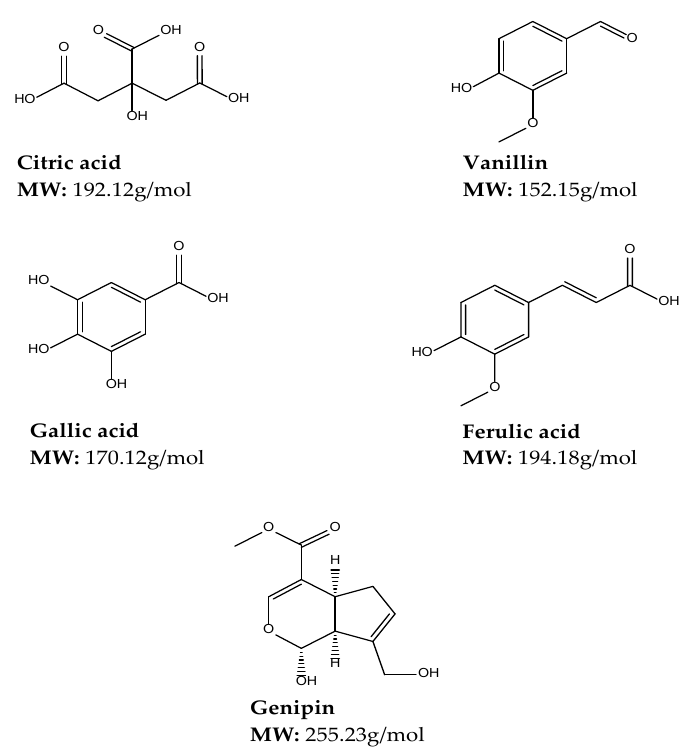
Figure 5. Chemical structures and molecular weights (MW) of various natural crosslinkers used to manufacture cross-linked gels.